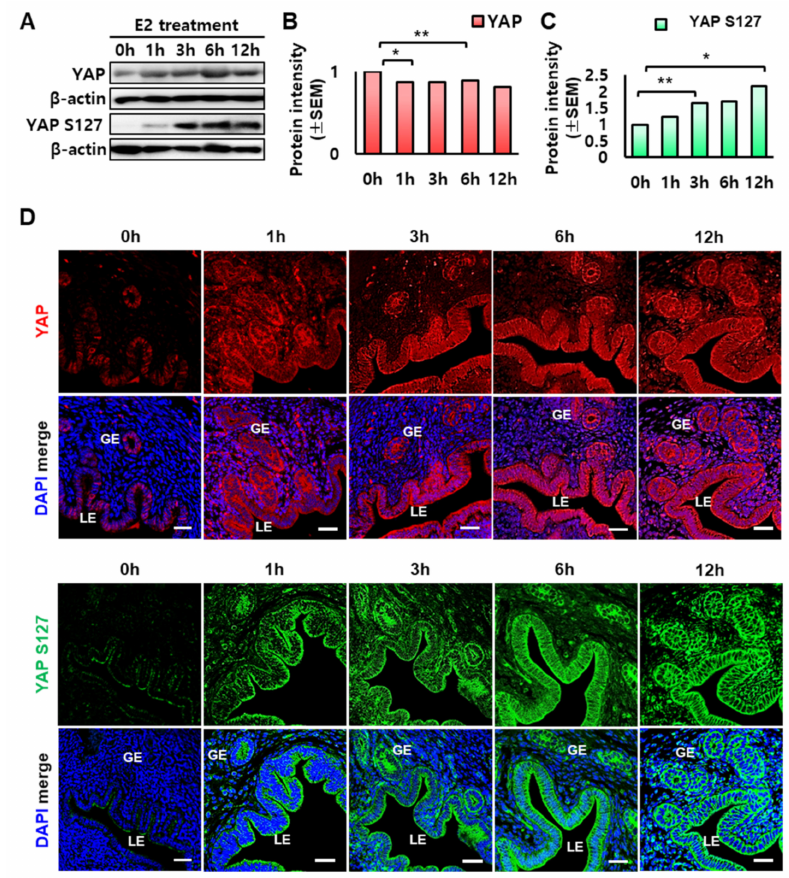
Figure 3. Effect of estrogen on YAP and phospho-YAP levels in the uterus of OVX mice. ( A ) Western blot analysis of YAP and phospho-YAP (YAP S127) proteins over time after estrogen treatment, 0, 1, 3, 6, 12 h (hour). ( B , C ) Relative quantification of western blot bands was performed using Image